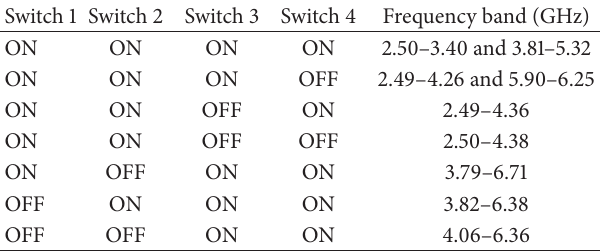
Table 1: Operating bands achieved when switches are ON/OFF [6].